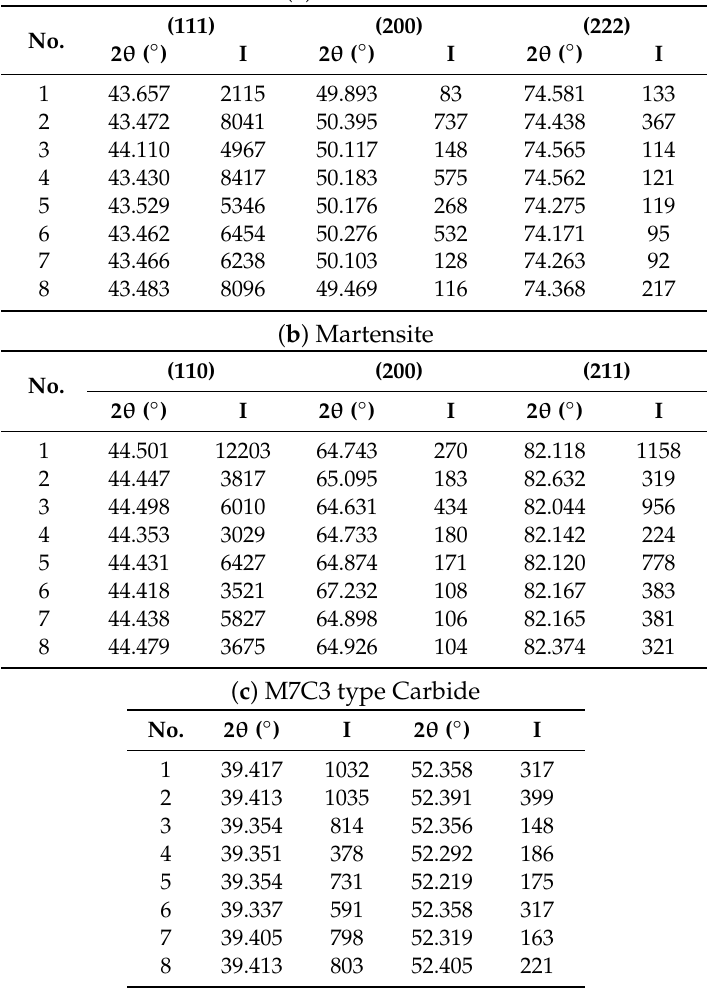
Figure 2. The di ff ractograms of the 8 experiments are shown in conjunction. The di ff erences in intensities of the Bragg peaks associated with each of the experiments can be appreciated. Table 4. The 2 θ ( ◦ ) and I (counts) values obtained from the fitting of the Bragg peaks. ( a )